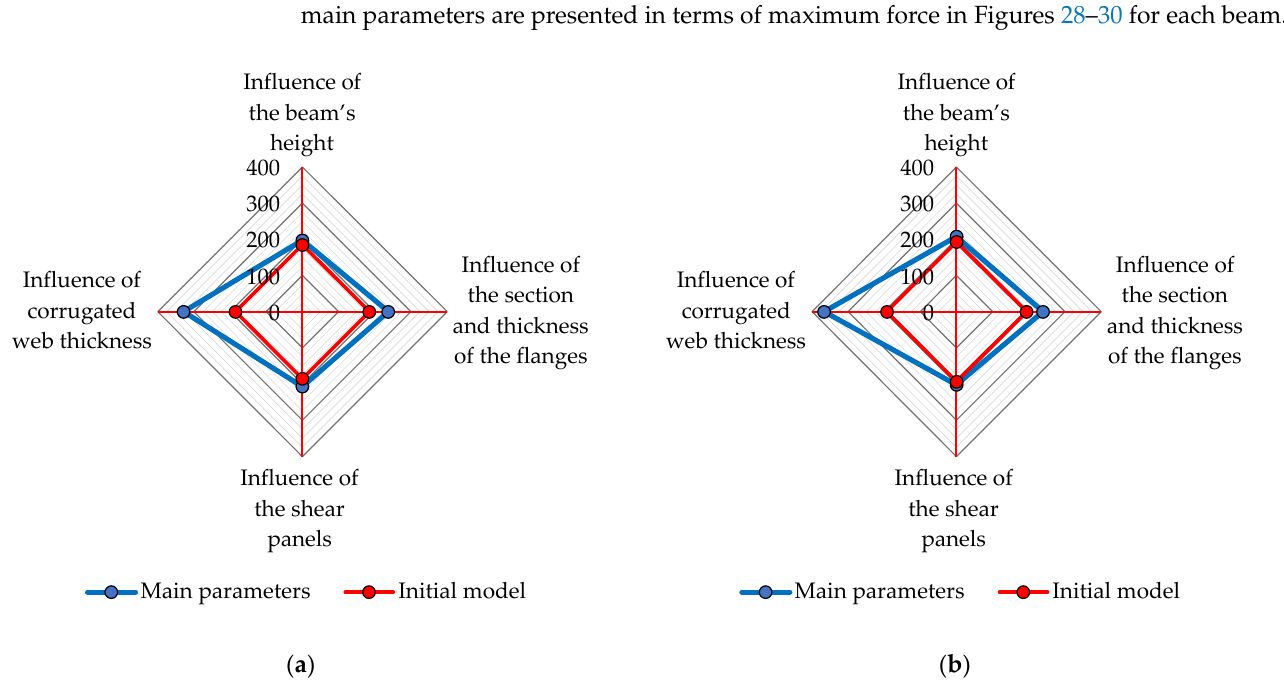
Figure 28. ( a ) Main parameters for the beam with a length of 6000 mm and a web opening; ( b ) main parameters for the beam with a length of 6000 mm without a web opening.